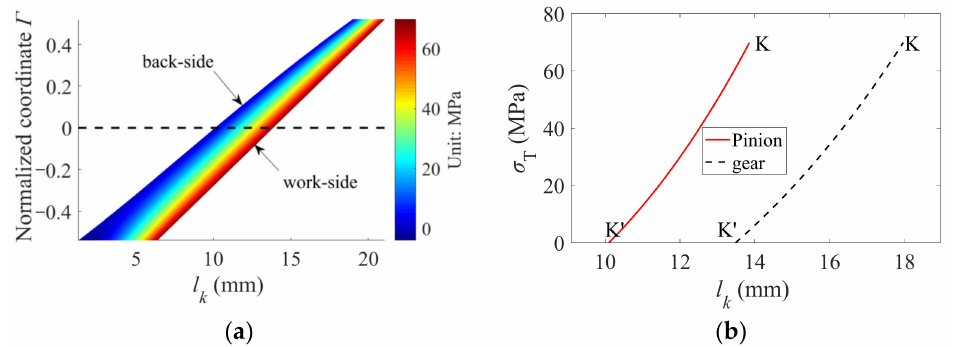
Figure 6. Thermal stress in the tooth profile plane: ( a ) thermal stress nephogram of the tooth profile plane; ( b ) distribution curves of thermal stress of pinion and gear at pitch point along l k .